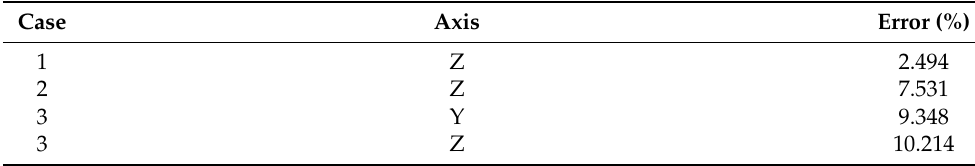
Table 2. Error for Timoshenko beams